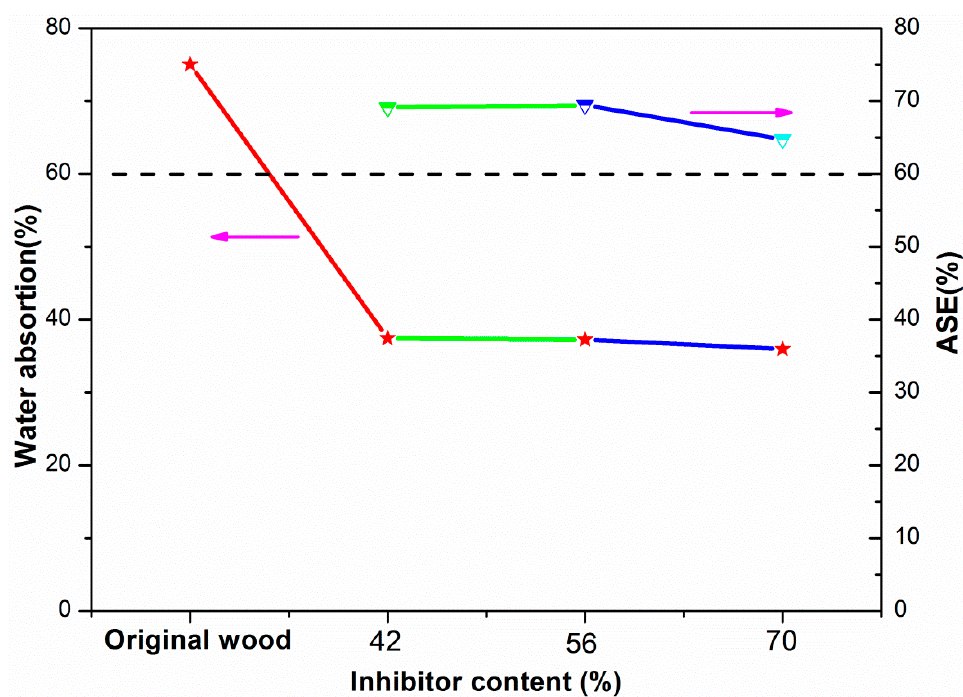
Figure 8. Water absorption rate over 24 h and anti-swelling efficiency (ASE) of original and modified wood at different inhibitor